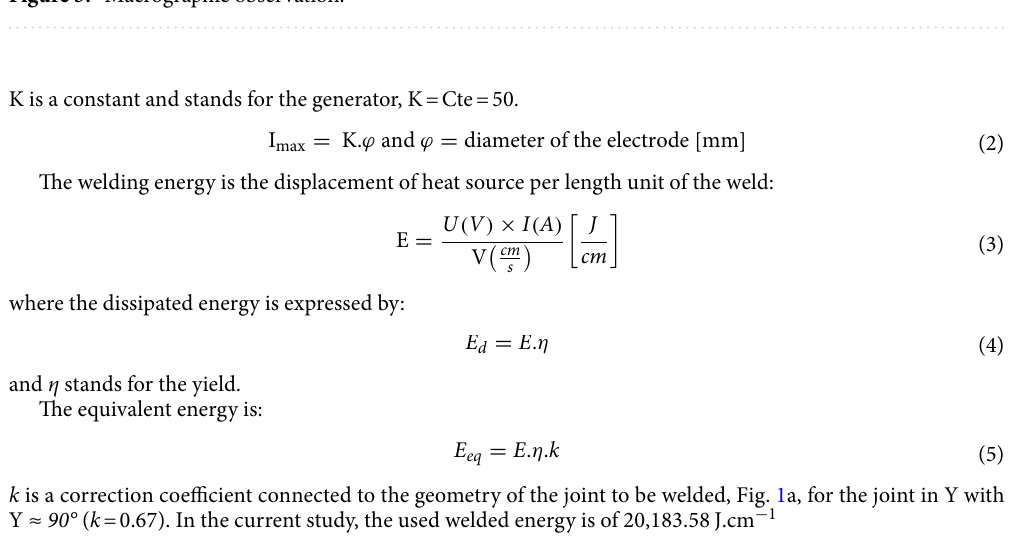
Figure 3. Macrographic